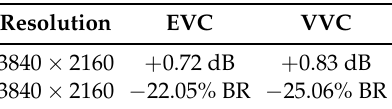
Table 3. Models comparison with respect to HEVC.